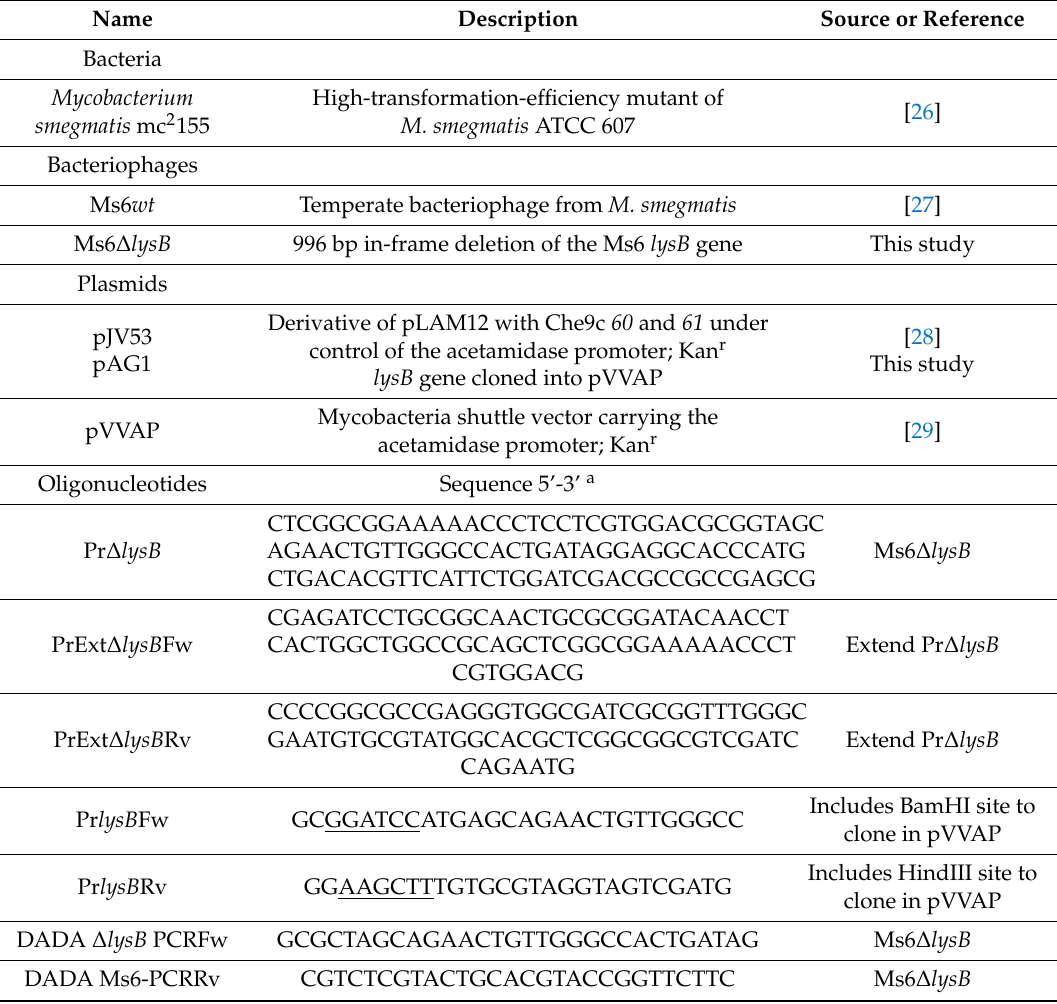
Table 1. Bacterial strains, phages, plasmids and oligonucleotides used in this